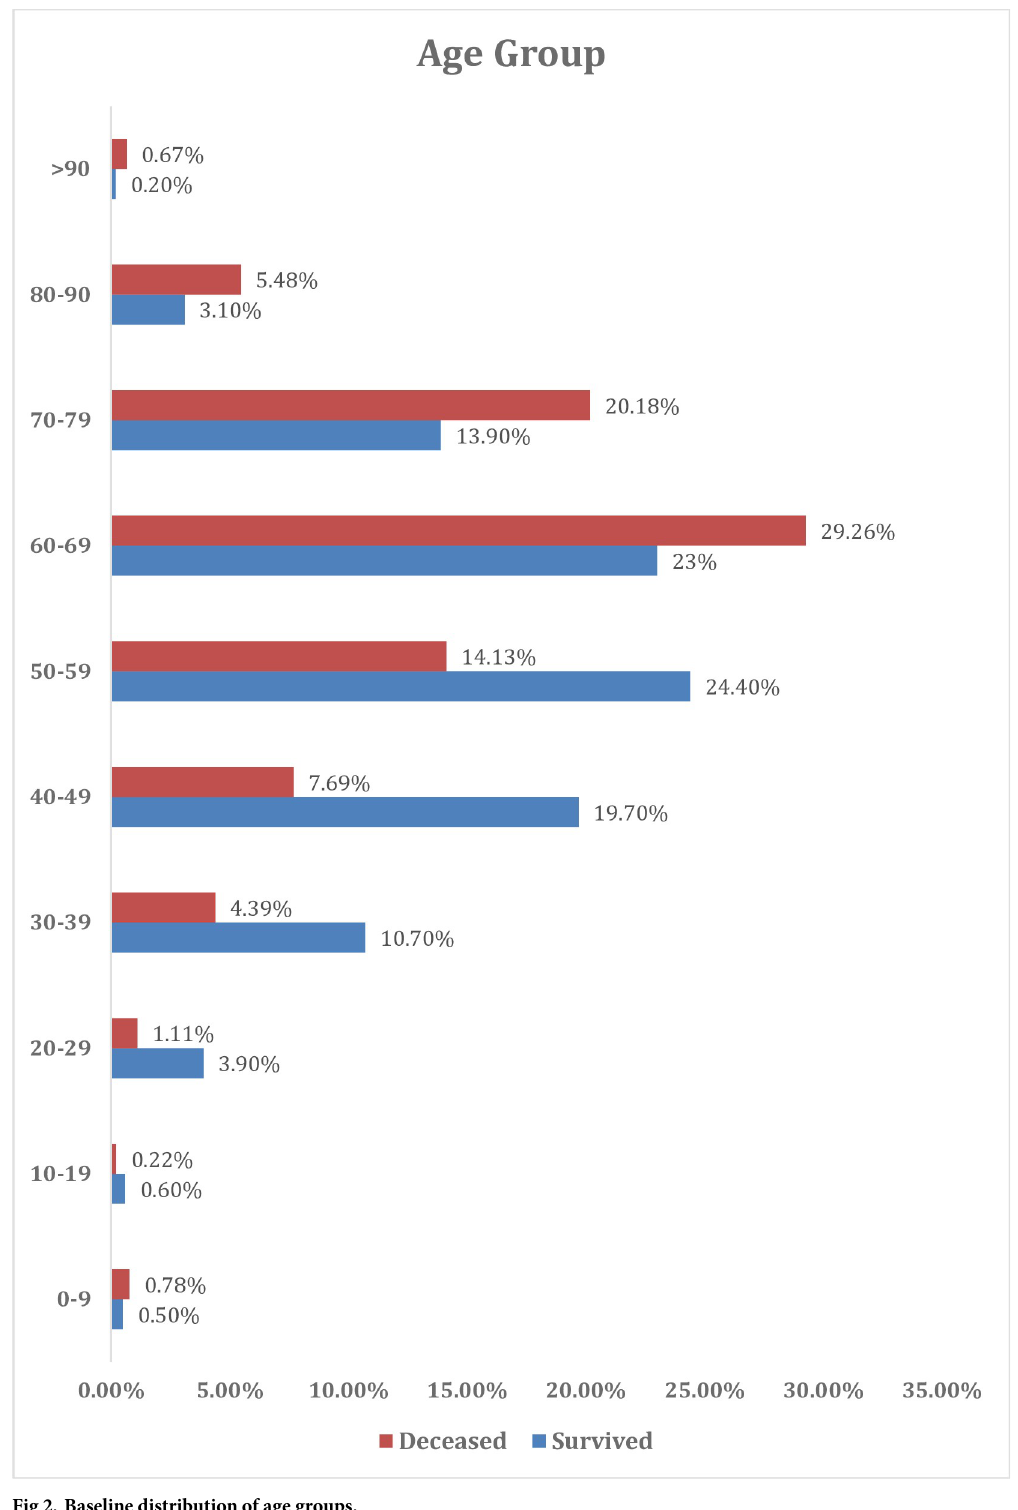
Fig 2. Baseline distribution of age groups.